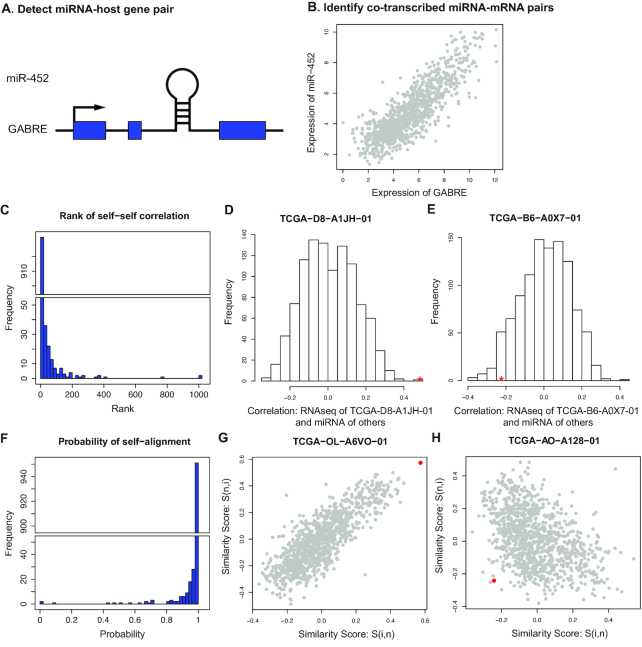
Aligning gene expression profiles by RNAseq and miRNAseq data. (A) An example of miRNAs (e.g., miR-452) that are embedded in gene regions (e.g., GABRE). (B) Expression level of miR-452 was highly associated with mRNA expression of GABRE. (C) The rank of the similarity scores of self-self RNAseq-miRNAseq profiles. (D) An example of the similarity score of the self-aligned profiles, TCGA−D8−A1JH-01. The similarity score between the RNAseq profile of TCGA−D8−A1JH-01 and the miRNA profiles of other samples are shown. The red asterisk indicates the similarity score of self-self RNAseq-miRNAseq profiles. (E) An example of non–self-aligned RNAseq-miRNA profiles, TCGA-B6-A0X7-01. (F) The probabilities of similarity scores (before multiplying prior probability) for self-aligned RNAseq-miRNAseq profiles. (G) An example of similarity scores of self-aligned RNAseq-miRNA profile pairs. The x-axis indicates the similarity scores between the RNAseq profile of TCGA-OL-A6VO-01 and the miRNAseq profiles of all other samples, and the y-axis indicates similarity scores between the miRNAseq profile of TCGA-OL-A6VO-01 and the RNAseq profiles of all other samples. The red dot indicates the similarity score for the self-self RNAseq-miRNAseq profile. (H) An example of similarity scores of non–self-aligned RNAseq-miRNA profile pairs.